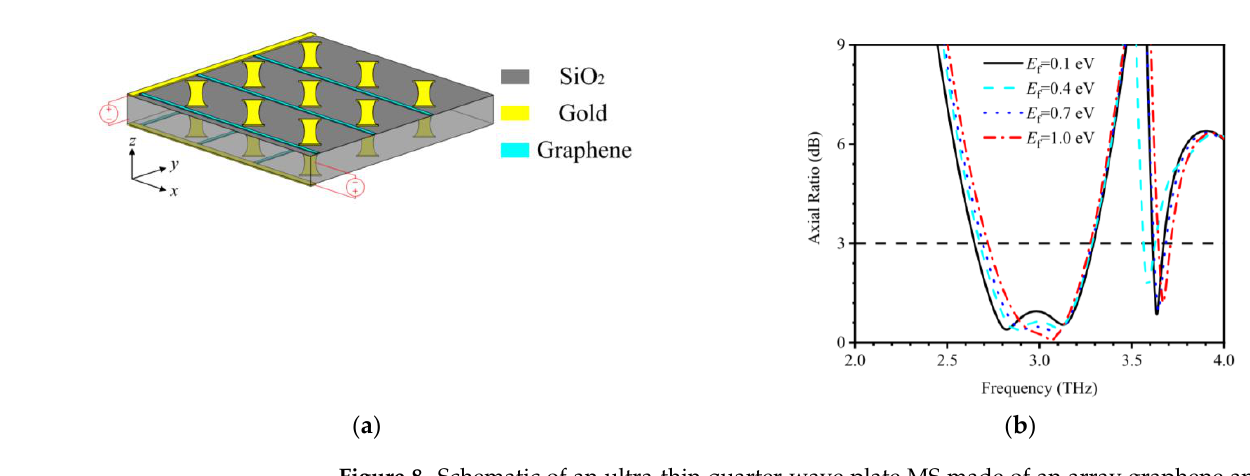
Figure 8. Schematic of an ultra-thin quarter-wave plate MS made of an array graphene and gold ( a ) periodic array configuration [109]. ( b ) The AR curves when Ef runs from 0.1 eV to 1.0 eV [109]. A similar scheme is applied to the far-infrared region, i.e., the phase retardation between two orthogonally polarized wave components is constructed through light propa- gation. Chen et al. implemented an LP-to-CP converter based on ultra-thin MS to operate in the mid-infrared region (Figure 9a) [110]. Simulated results for transmission are shown in Figure 9b. It is clear that in the wavelength 2729 ~ 3094 nm, the phase difference of 90° between transmitted orthogonal waves is achieved. Figure 9c shows the SEM image for the fabricated sample.